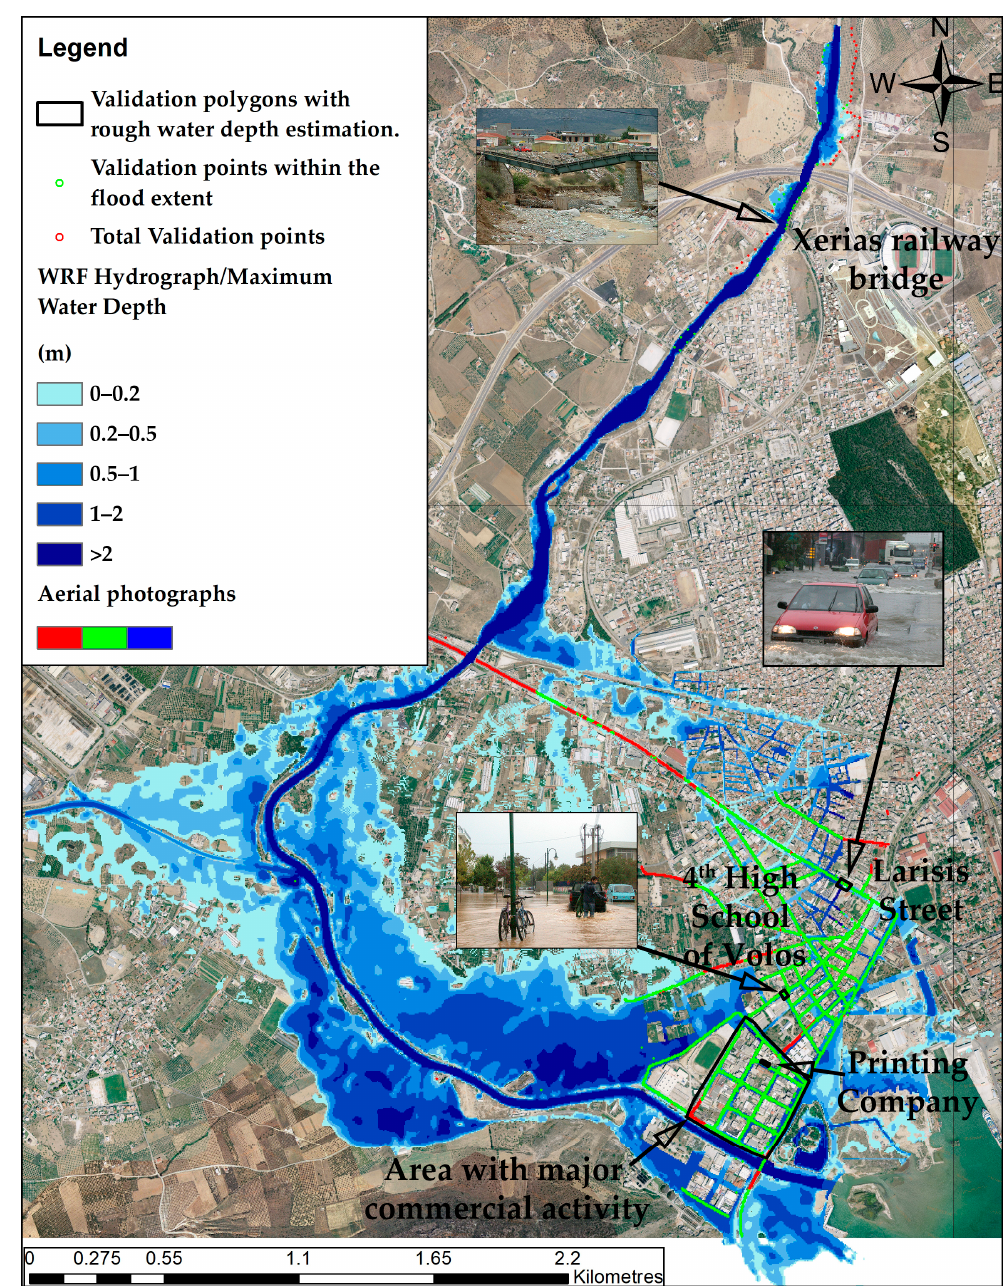
Figure 11. Maximum water depth and flood extent simulated by the 2D HEC-RAS model using the WRF hydrograph. Red dots represent the collected validation points, whereas green dots represent the validation points observed within the simulated flood extent. The areas used for rough water depth estimation–validation are depicted with black polygons.